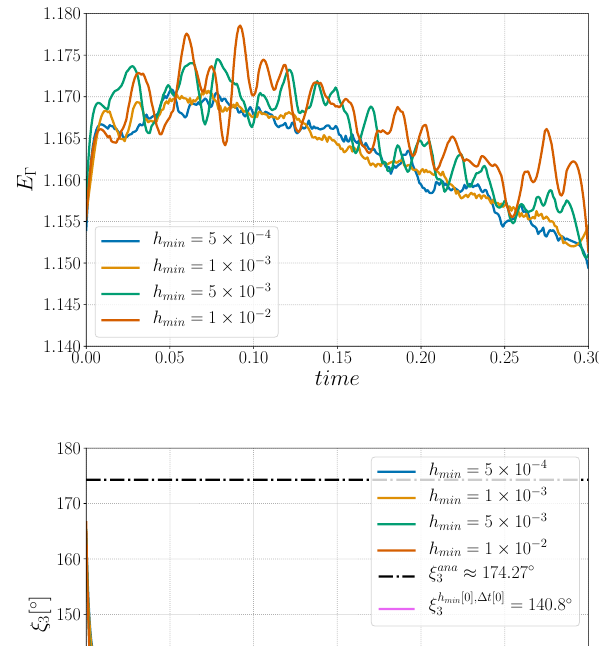
Figure 7. Sensibility analysis for the Aniso formulation in ( left ) time for h min = 1 ∆ t = 1 10 − 4 : ( Top ) interfacial energy sensibility, ( middle ) triple junction angle, ξ 3 , sensibility analysis, and ( bottom ) × triple junction velocity, v TJ , sensibility